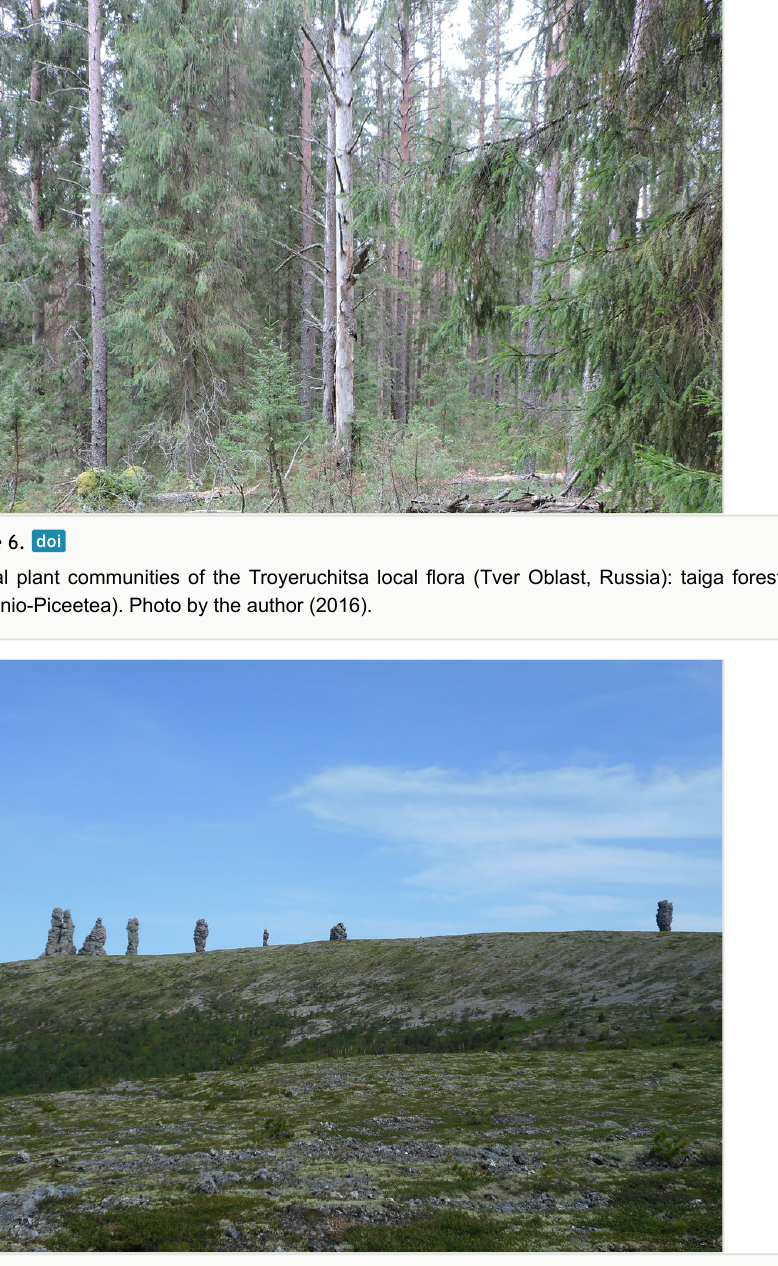
Typical plant communities of the Man-Pupu-Ner local flora (Komi Republic, Russia): tundra (Loiseleurio–Vaccinietea) above timber-line, 700-750 m a.s.l. Photo by the author